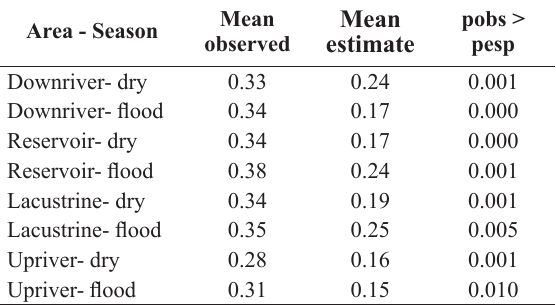
Probability test of null models (RA3) between the mean observed and expected trophic niche overlap for fish assemblages in the areas of influence of Coaracy Nunes Dam (State of Amapá, Brazil). (p-value = pobs averages observed; pesq = p-value of expected